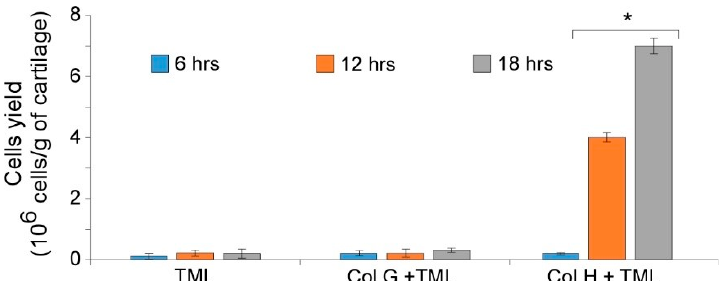
Figure 3. Performance of ColG and ColH in cell release from cartilage using ColG and ColH in the presence of TML at different times (6, 12, and 18 h).